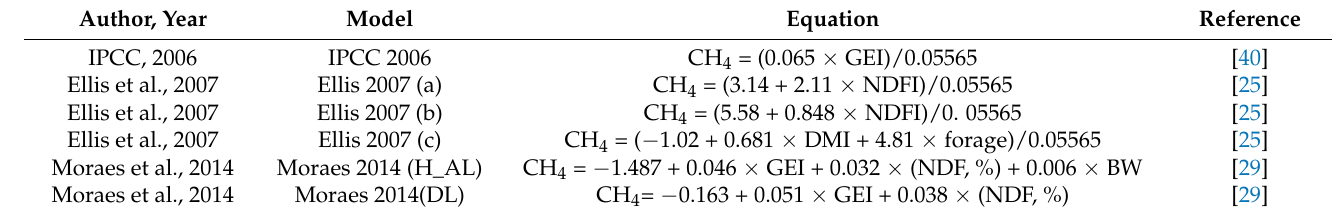
Table 2. List of authors, models, equations and references to estimate CH 4 emissions evaluated in this